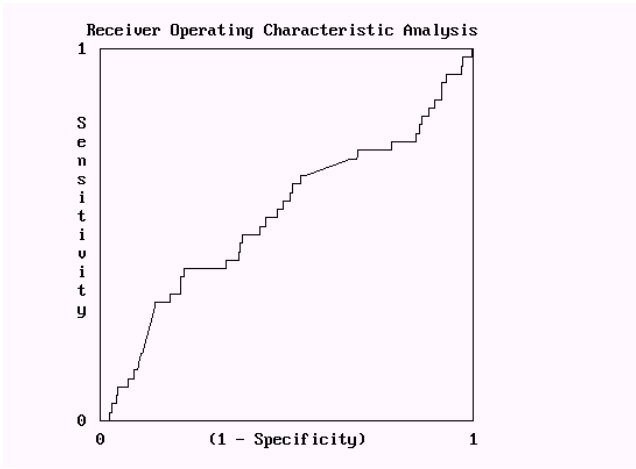
FIGURE 1A. ROC curve mortality within 90 days of discharge logistic regression. Test data: ______ Az: 0.55.